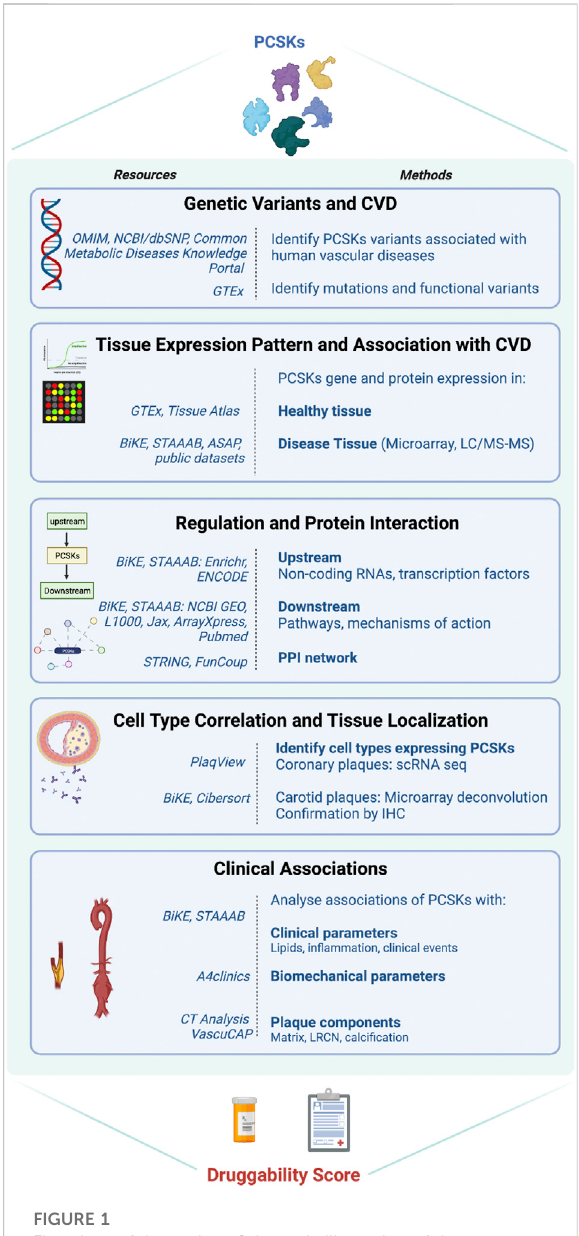
FIGURE 1 Flowchart of the project. Schematic illustration of the different work-packages, methods, resources used in each